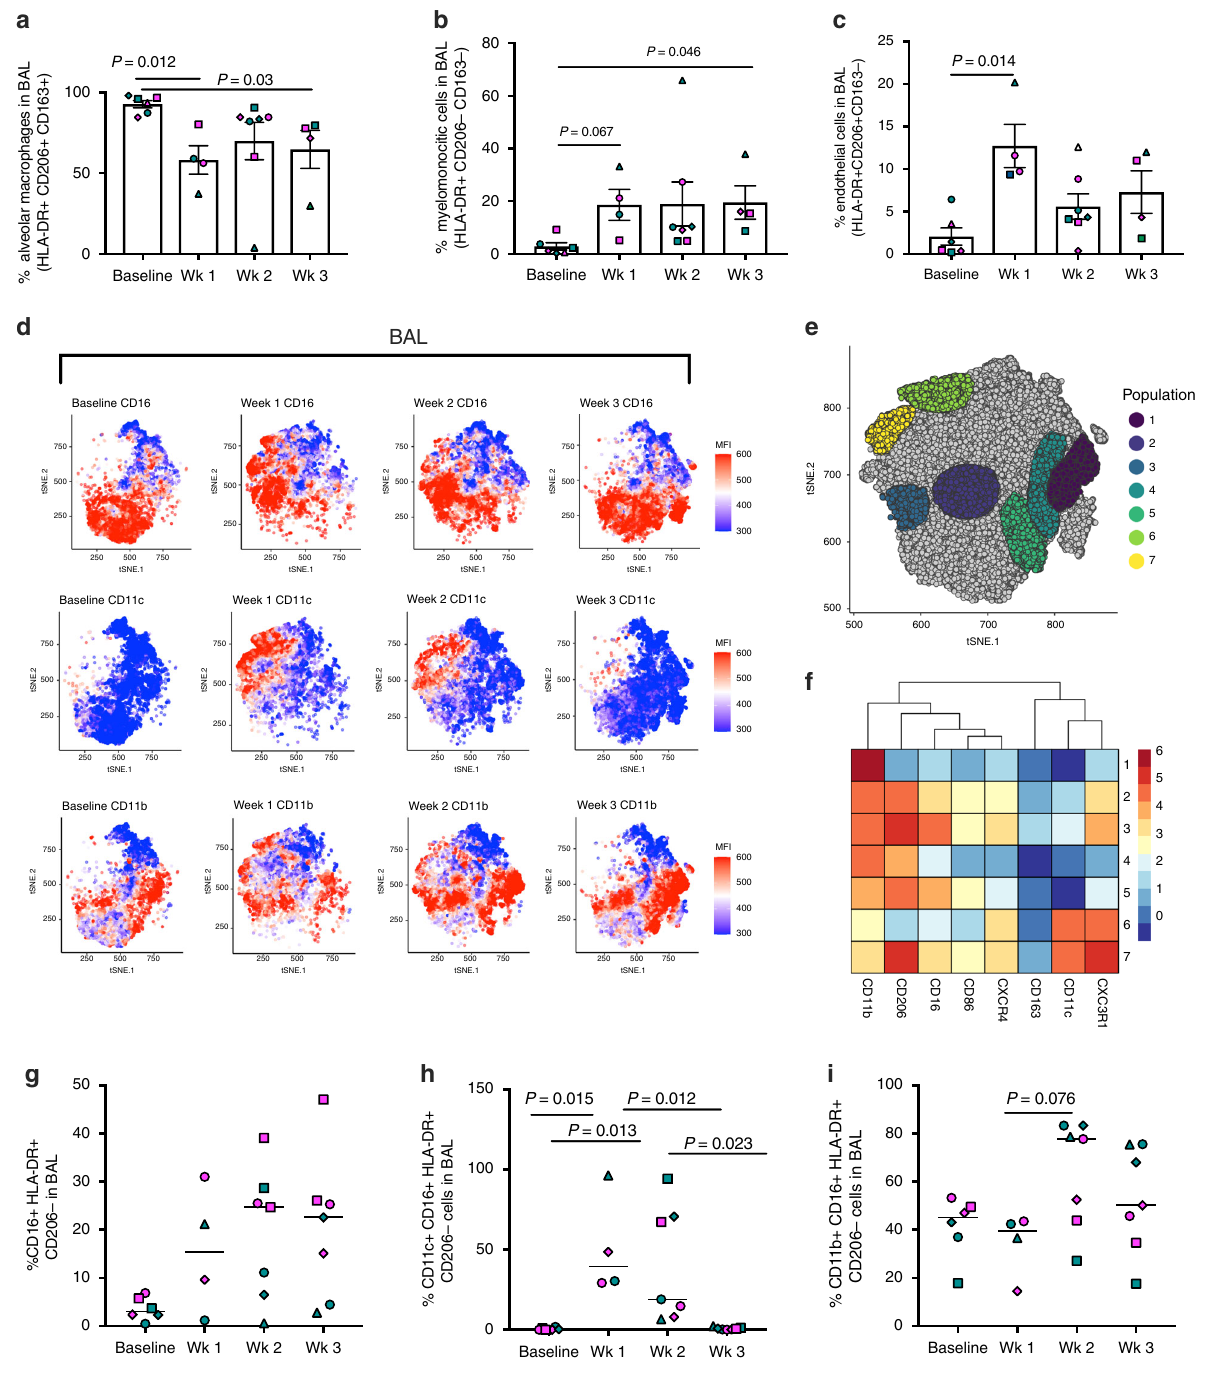
Fig. 2 Myelomonocytic cells increase in BAL is associated with IL-6. a Decrease of alveolar macrophages (de fi ned as HLA-DR + CD206 + CD163 + cells) in the BAL after infection. b Increase in the frequency of myelomonocytic in fi ltrates (de fi ned as HLA-DR + CD206 − CD163 − ) and c of endothelial cells (de fi ned as HLA-DR + CD206 − CD163 + ) at infection in BAL (1wk pi). For fi gure a – c , n = 7, 4, 8, 4 for baseline weeks 1, 2, and 3 time points, respectively, and analyzed by the Kruskal – Wallis test, Dunn ’ s multiple comparison test. The bars represent mean and standard error. d tSNE plots displaying kinetics of expression of CD16, CD11b, and CD11c markers on live/ HLA-DR + cells populations in BAL before and after infection. e Gating of CD11c + and CD11b + populations on the tSNE map based on antigen expression and discrete density clustering. f Characterization of populations shown in e . The heatmap depicts the fold-change values of each antigen compared to the channel values of negative-expressing cell populations. g Increase in the percentage of CD16 + HLA-DR + cells and h in the percentage of interstitial macrophages (CD16 + CD206 − HLA-DR + ) expressing of CD11c and i CD11b in BAL overtime (baseline n = 8, week 1 n = 4, week 2 and 3 n = 7; Kruskal – Wallis test, Dunn ’ s multiple